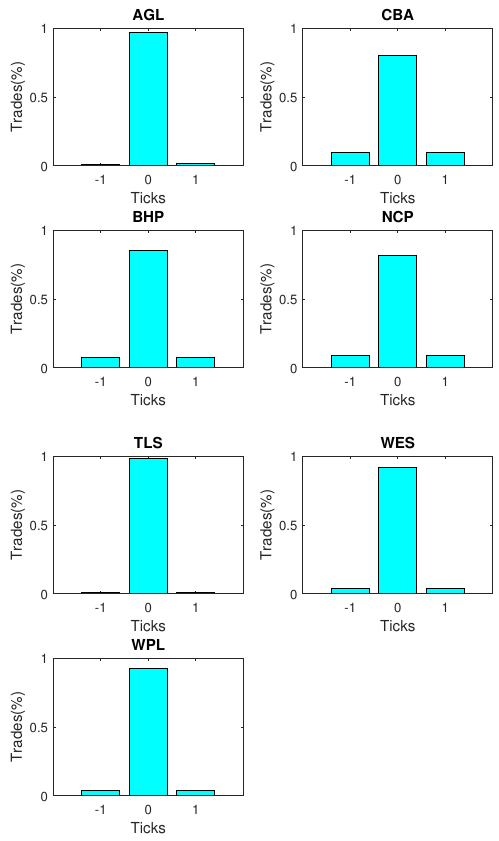
Figure 4. Distribution of the number of trades over the three categories of price change in terms of ticks, for all stocks during the